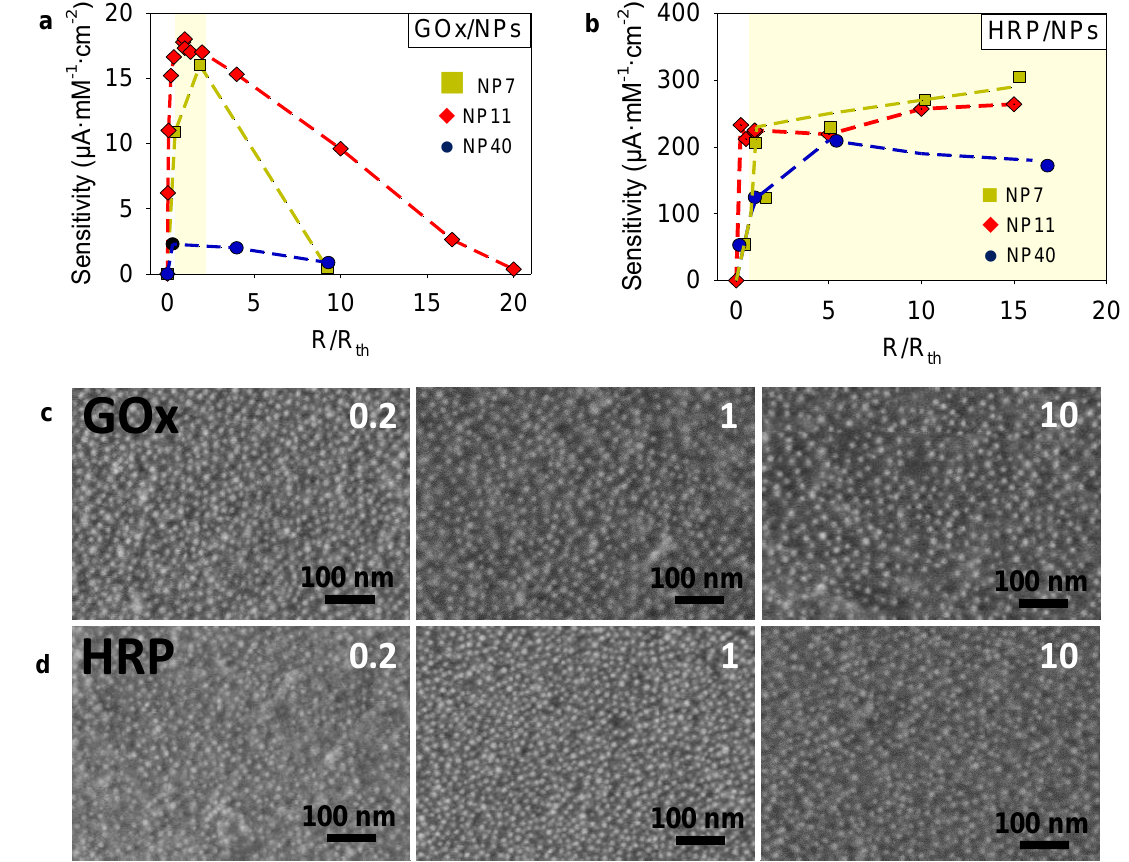
Figure 5. Characterization of GOx/NPs and HRP/NPs coatings. Evolution of the sensitivity of: ( a ) GOx/NPs and ( b ) HRP/NPs coatings with NP7, NP11, and NP40 as a function of the mixture ratio, R / R th , with R , the enzyme/NPs ratio of the electrodeposition solution and R th , the theoretical enzyme/NPs molar ratio to obtain an enzyme monolayer at the surface of NPs (dashed line as a guide to the eye). SEM micrographs, with secondary electrons detector of ( c ) GOx/NP11 and ( d ) HRP/NP11 coatings obtained at different enzyme/NP ratios, the number of each corresponds to the R / R th value.